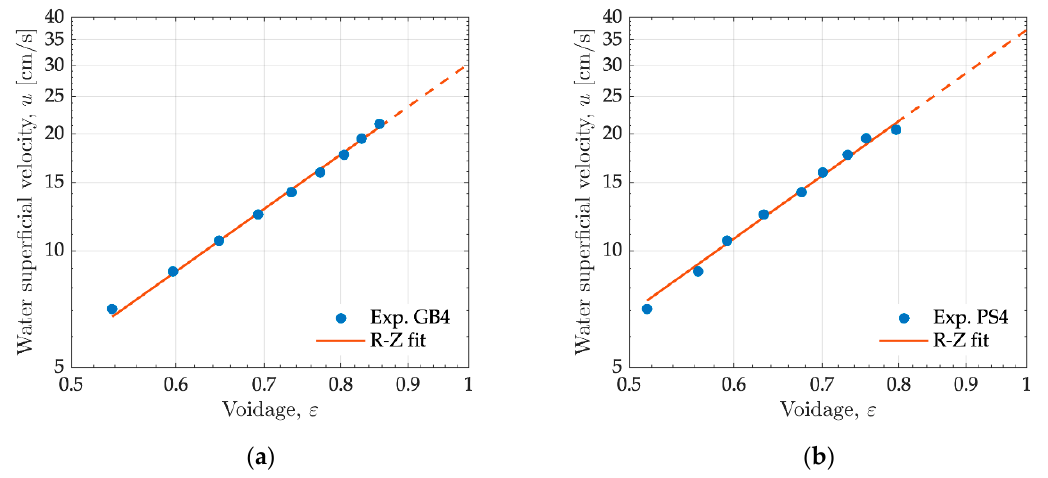
Figure 4. Expansion properties of one sample of glass beads, GB4, ( a ) and plastic spheres, PS4, ( b ). The parameters of the fitting lines are reported in Table 2 and compared with empirical correlations. Table 2. Slope and intercept parameters of the fitting lines for the expansion of solids GB4 (Figure 4a) and PS4 (Figure 4b). Correlations for the Richardson–Zaki exponent, terminal velocity and wall correction factor, see Equation (15), are reported in Epstein [6] (Chapter 26).